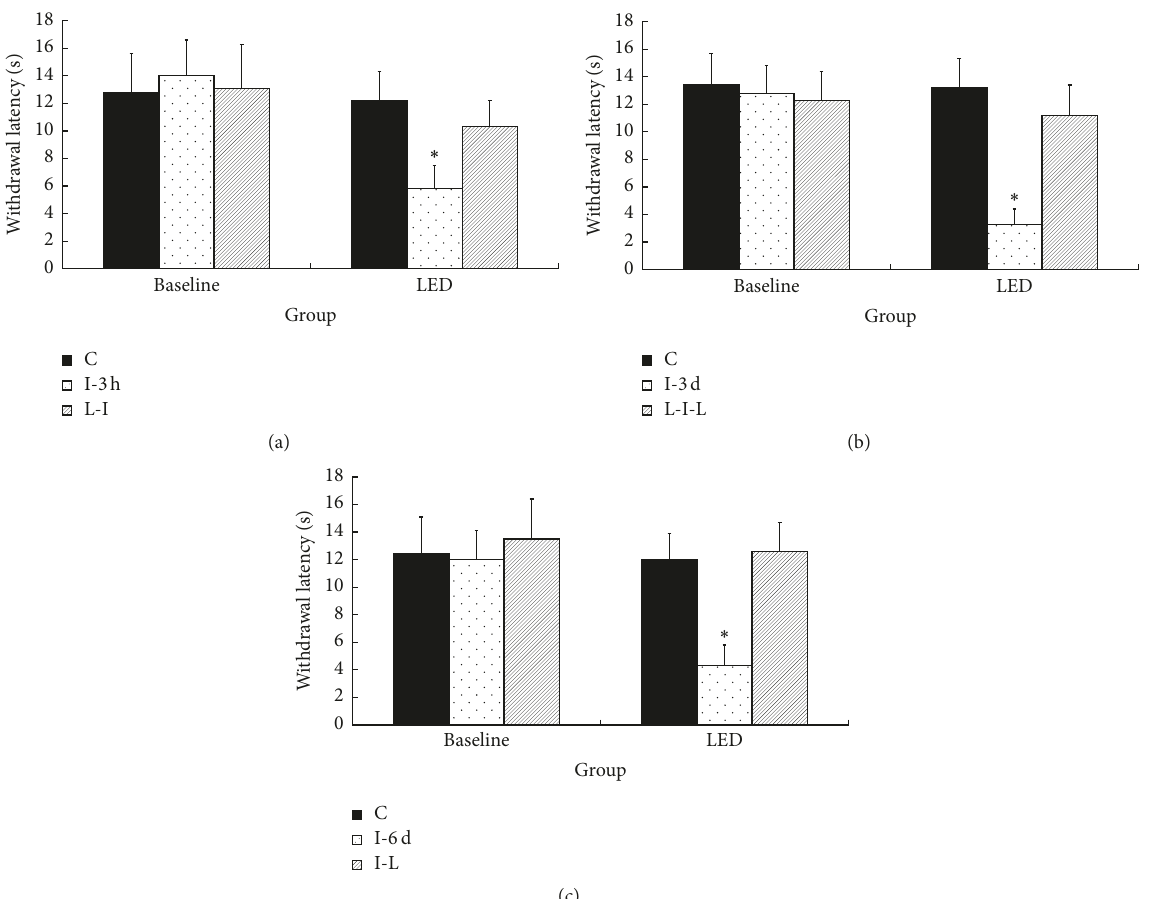
Figure 1: Mean withdrawal latency in the six groups ( 𝑛 = 6 each group) 6 days after LED irradiation performed before or after skin incision. C indicates LED irradiation for 6 days before or after sham skin incision on the paw contralateral to the LED-irradiated incised paw; I-3h, I-3d, and I-6d indicate incision only groups that underwent behavioral testing 3 hours, 3 days, and 6 days after skin incision; L-I indicates LED irradiation for 6 days before skin incision; I-L indicates LED irradiation for 6 days after skin incision; L-I-L indicates LED irradiation from 3 days before skin incision to 3 days after skin incision. ∗ 𝑝 < 0.05 compared with the baseline value in each group. The values represent the means ±